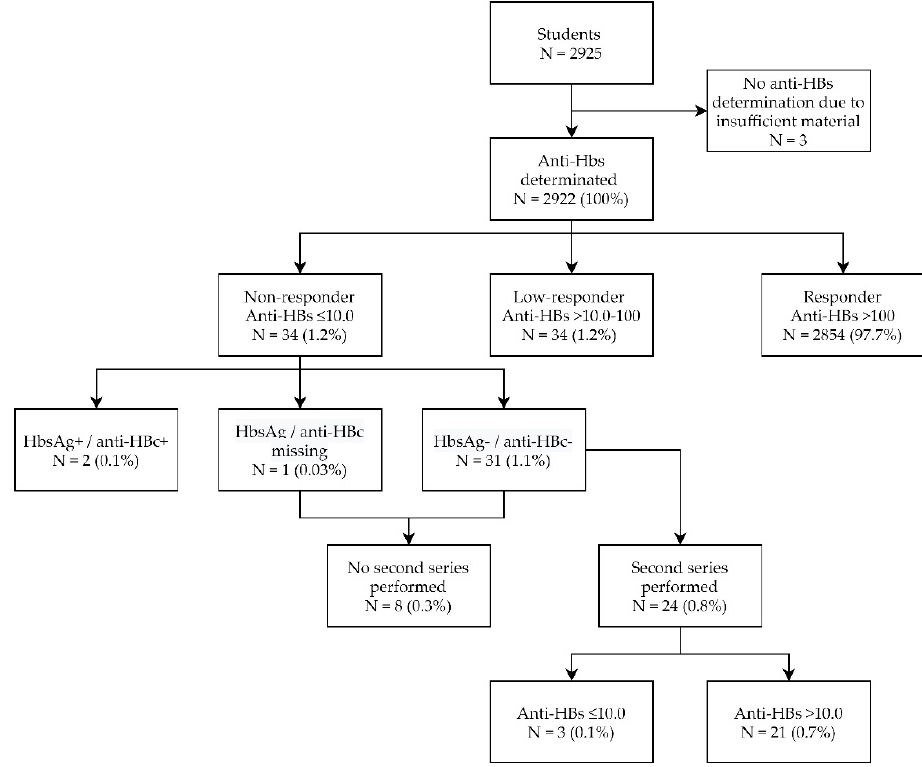
Figure 1. Evaluation of the occupational vaccination of students from May 2012 to November 2019.